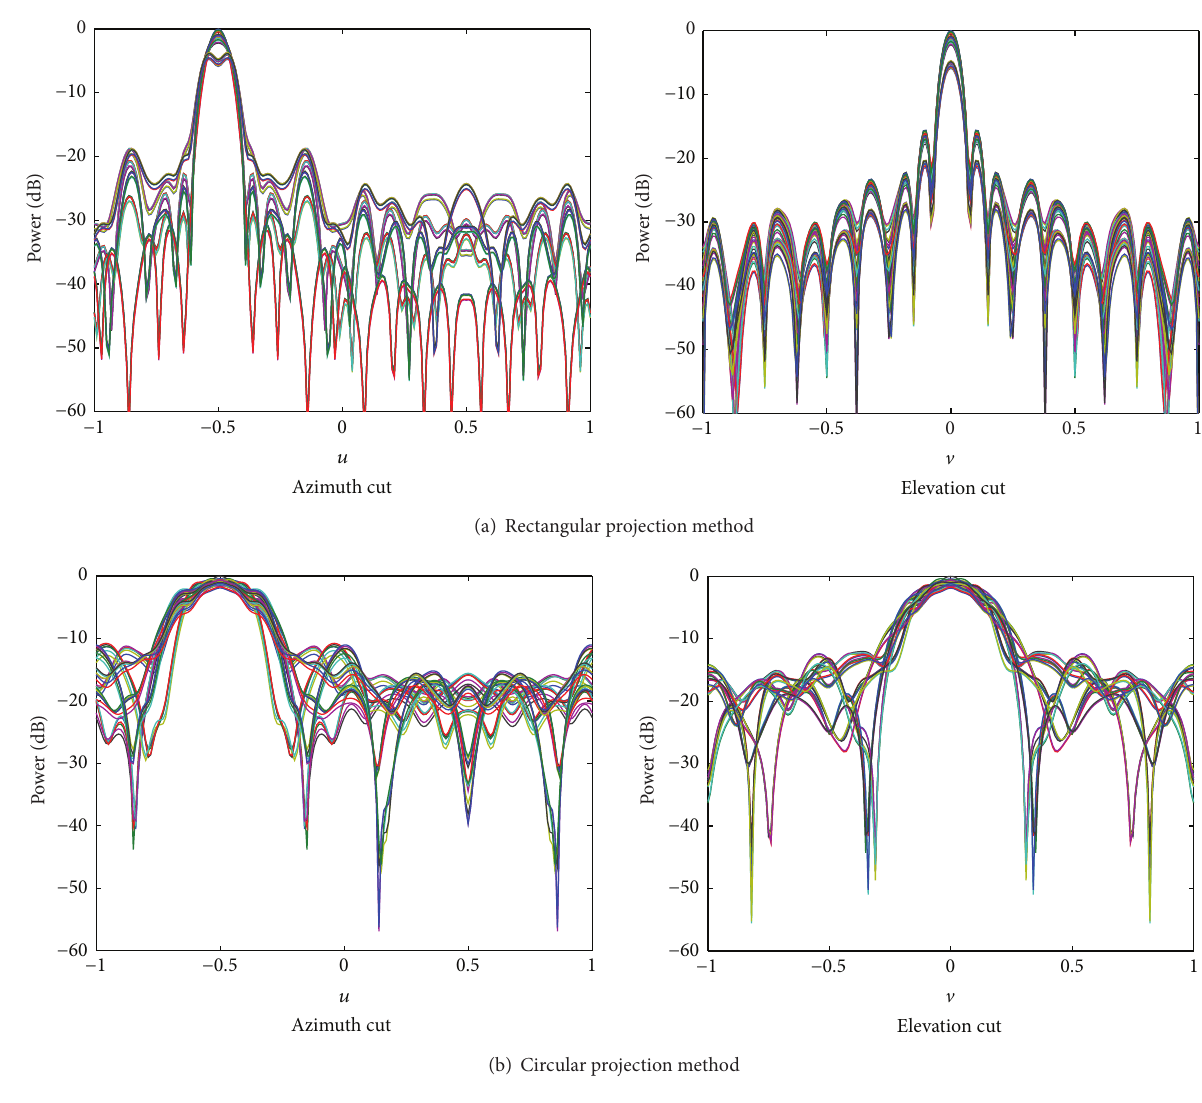
Figure 13: Subarray patterns obtained by